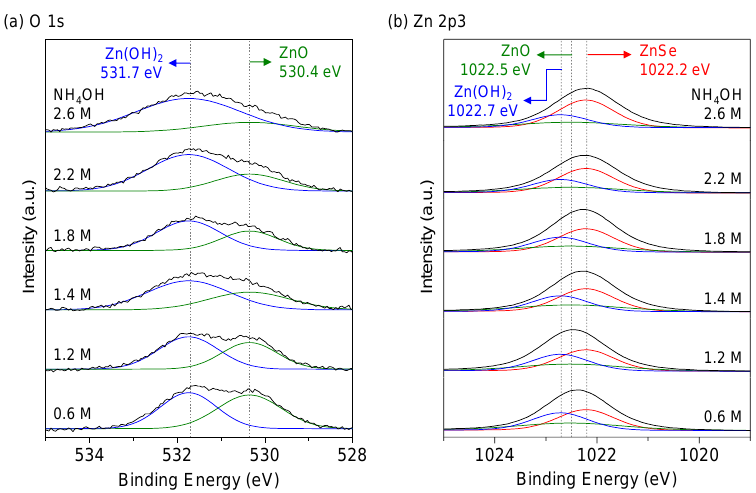
Figure 9. After sputtering for 120 s, ( a ) oxygen 1s and ( b ) zinc 2p3 binding-energy spectra of Zn(Se,OH) films deposited with selenourea concentration of 0.03 M and ammonia concentrations in the range of 0.6 to 2.6 M.